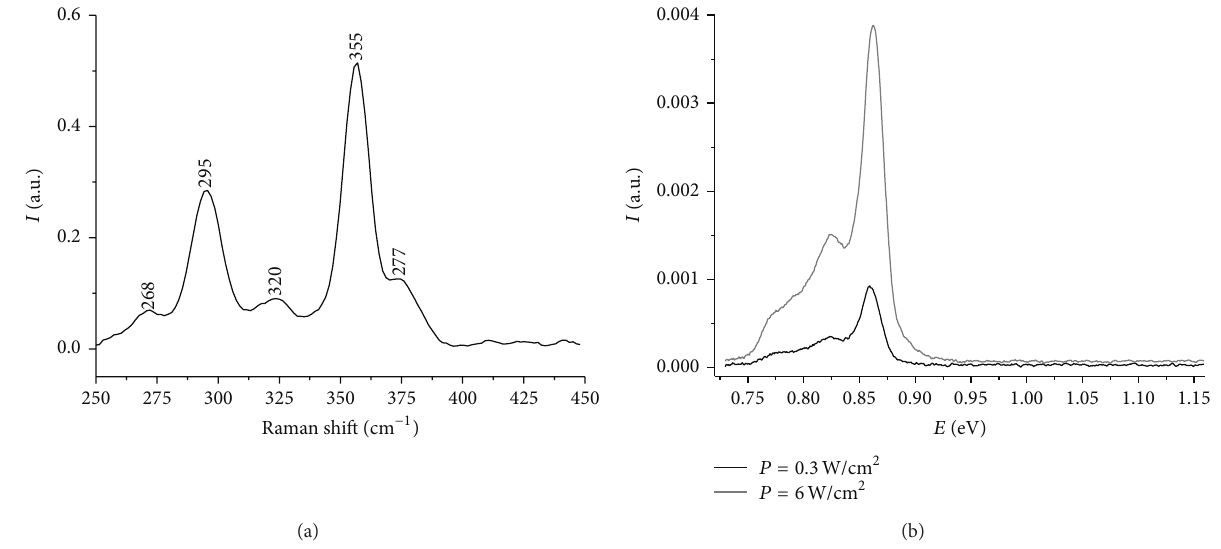
= 1064 nm) on the as-grown CTS exc